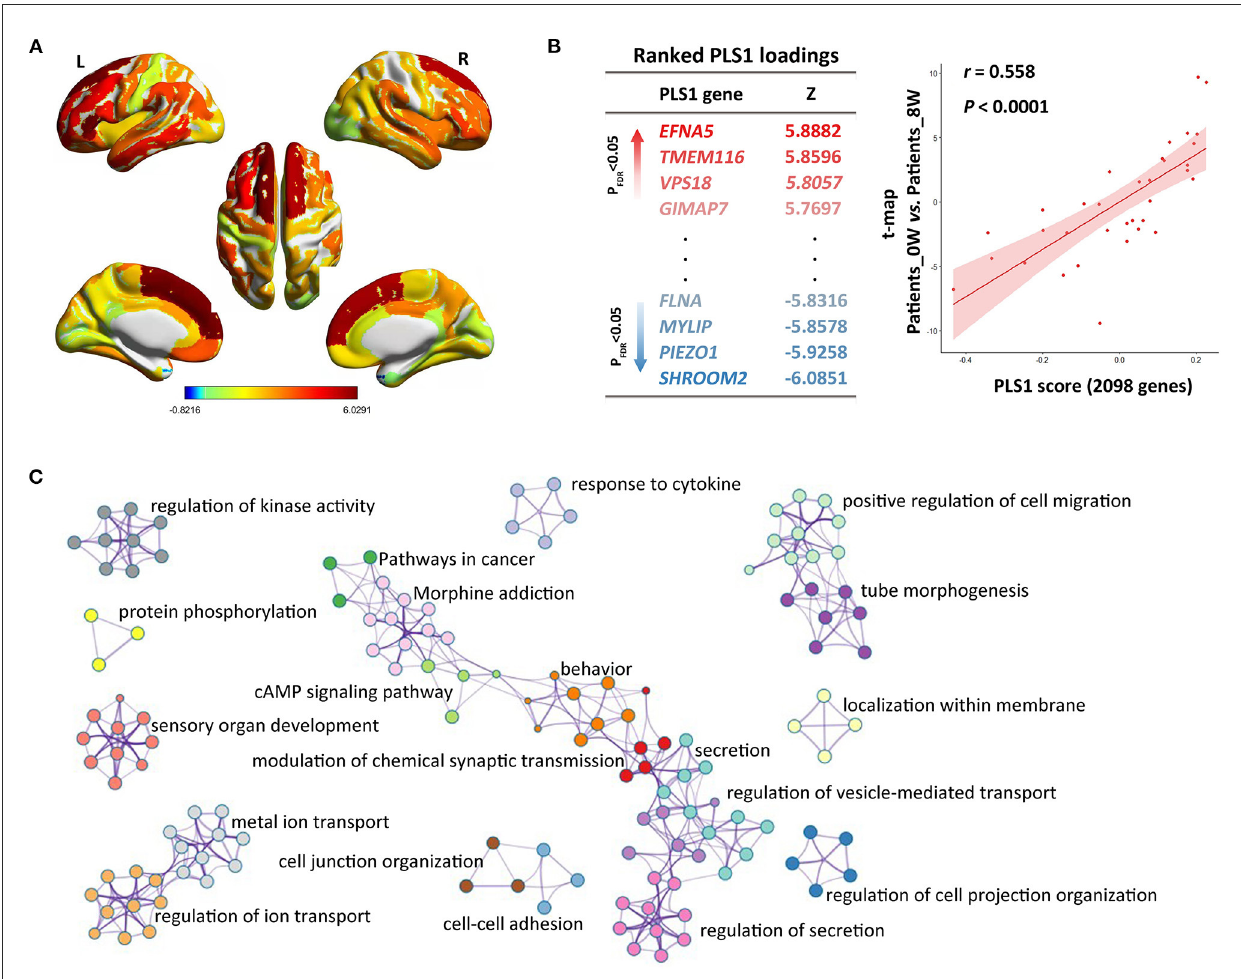
FIGURE2 Imaging-transcriptomic analysis treatment-related biomarkers. (A) T-statistic map was constructed for the paired comparison of cortical thickness between Patients_0W and Patients_8W; (B) Partial least squares (PLS) regression analysis showed that expression levels of 2098 genes in the PLS1 were spatially associated with the above brain image t-map; (C) We used Metascape to align the GO biological processes as well as KEGG pathways for the PLS1